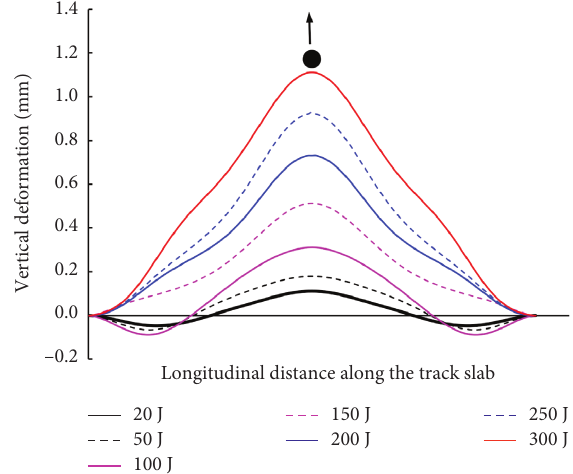
Figure 13: The maximum rebound deformation for the selected side of the track slab for different impact